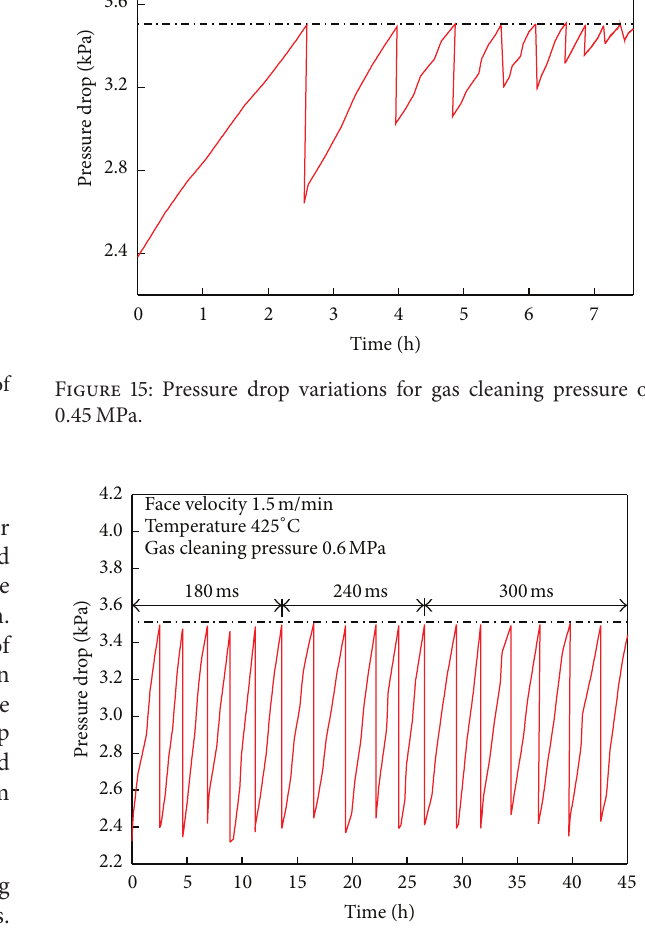
Figure 16: Pressure drop variations for pulse durations of 180ms, 240 ms, and 300